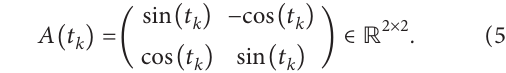
A − 1 k + 1 (i.e., k + 1 ) and by ZMMMI10i algorithm (33) for example 1 (with ϵ and x . (b) Trajectories of y and x . (c) Trajectories of y 11 11 12 12